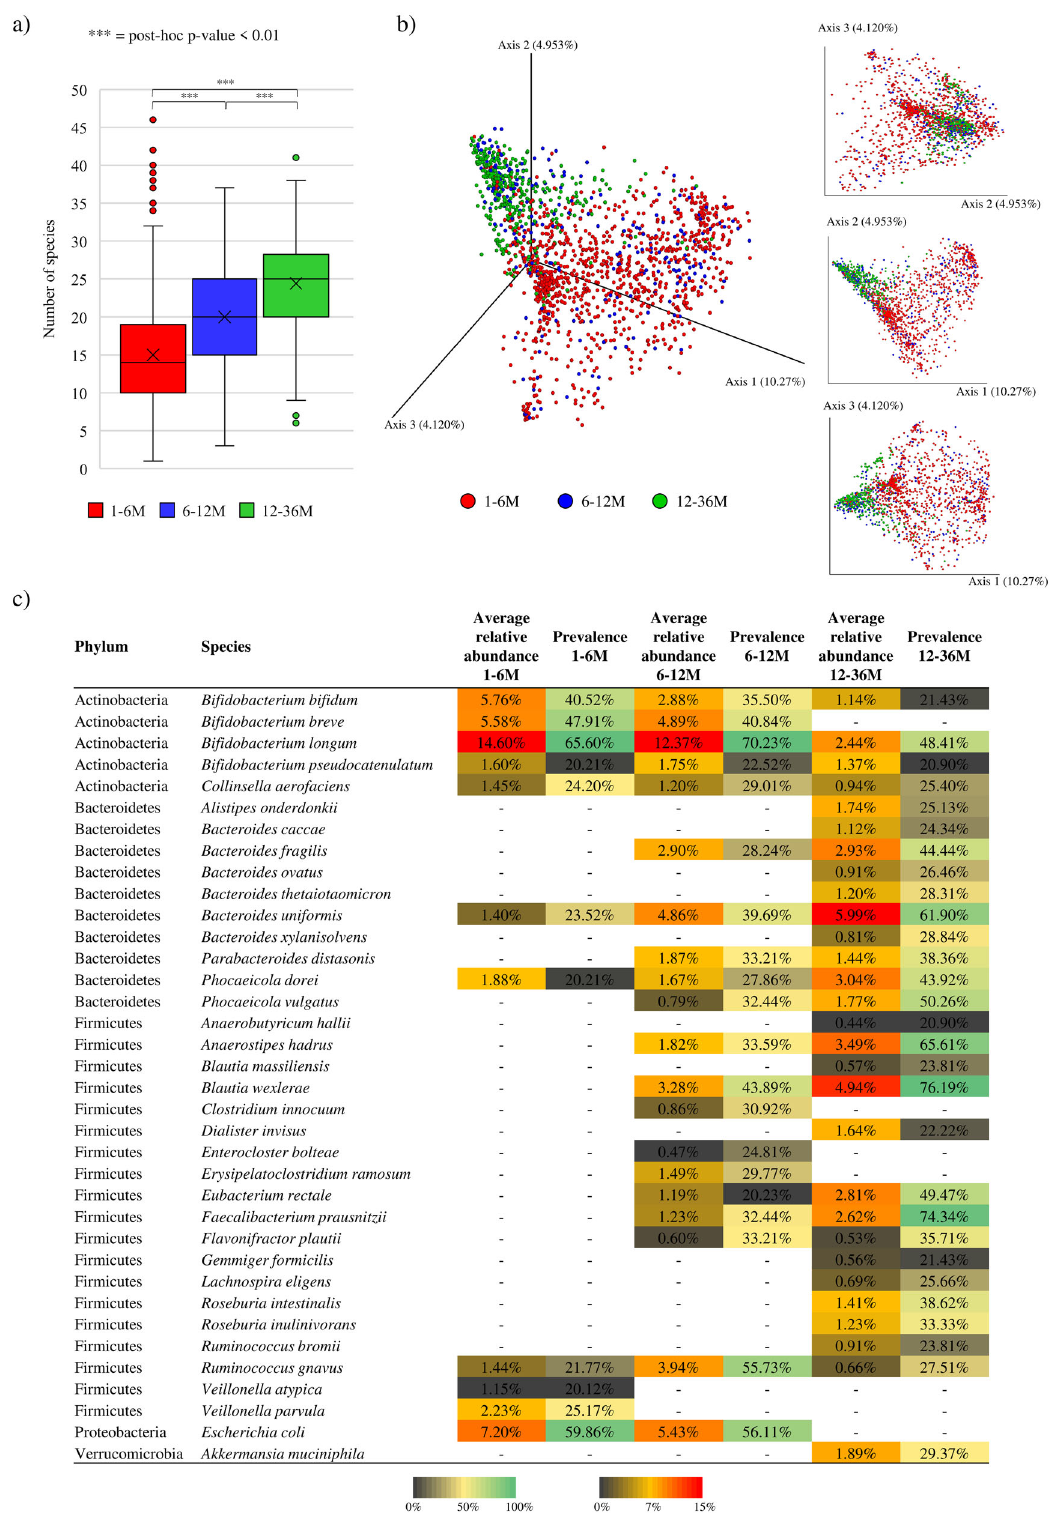
Fig. 1 Evaluation of the bacterial diversity and taxonomic composition of healthy infant fecal samples over time. Panel a shows the box and whisker plot of the calculated species-richness based on the number of bacterial species observed in the three age group. The x-axis reports the three considered age groups, while the y-axis shows the number of bacterial species. Boxes are determined by the 25 th and 75 th percentiles. The whiskers are determined by the maximum and minimum values and correspond to the box extreme values. Lines inside the boxes represent the average, while crosses correspond to the median. Panel b displays both the two- and three-dimensional Bray-Curtis dissimilarity index-based PCoA of the 1669 selected infant fecal samples subdivided by age groups. Panel c reports the average relative abundance and prevalence of bacterial species corresponding to the core and accessory gut microbiota of each age